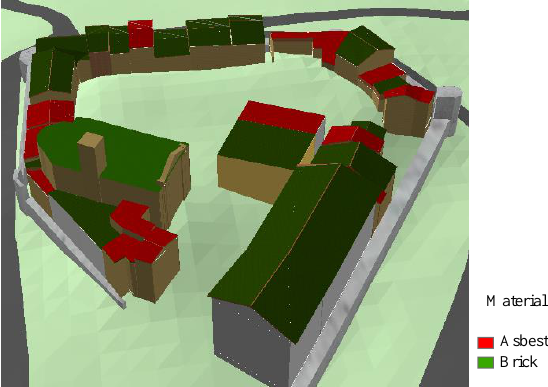
Figure 15. Mapping Volume [mc]